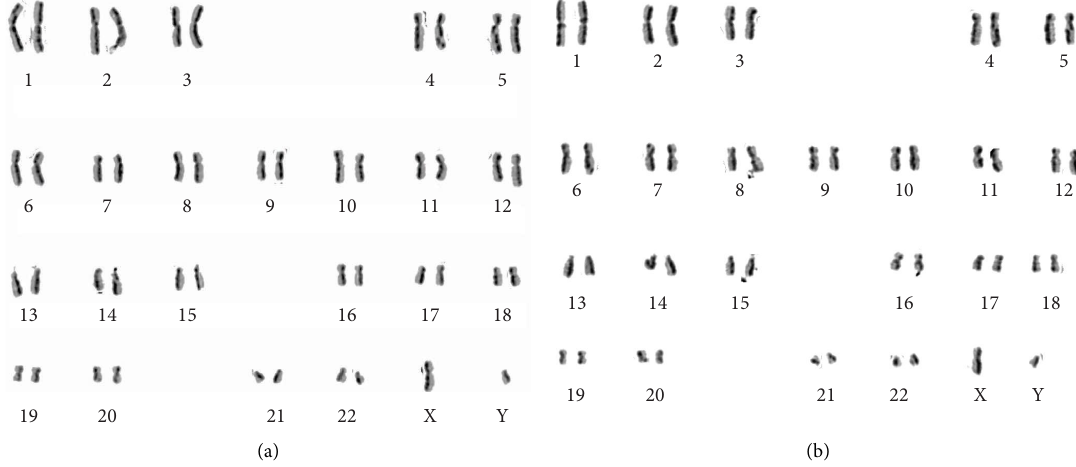
Figure 4: Sample SCE metaphases: (a) control (+) as MMC; (b) GPE3 (100 μ M) treated